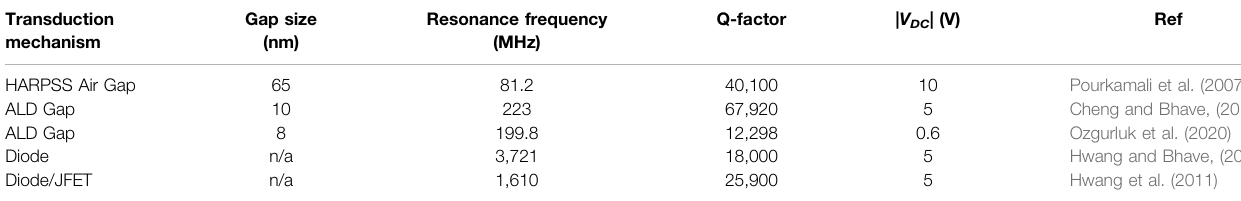
TABLE 2 | Overview of several approaches to scaling capacitive transduction via shrinking air gap thickness and utilization of depletion capacitance actuation. Transduction